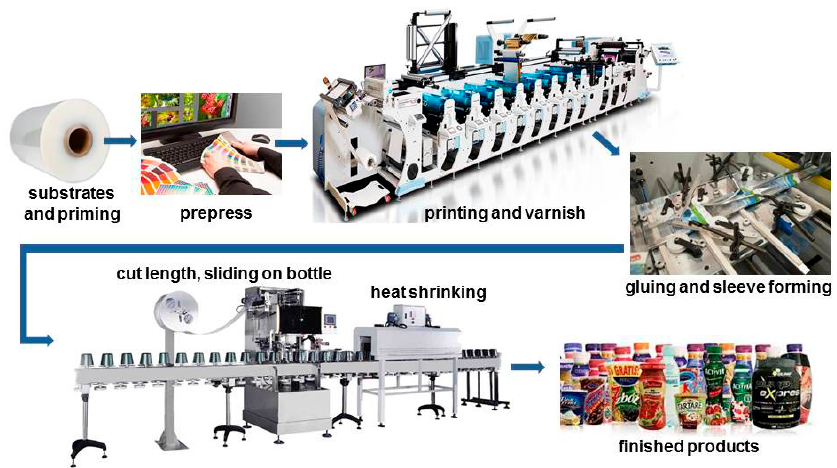
Figure 2. The production and application process of the heat-shrinkable label. (Adapted from resources of Masterpress S.A.).